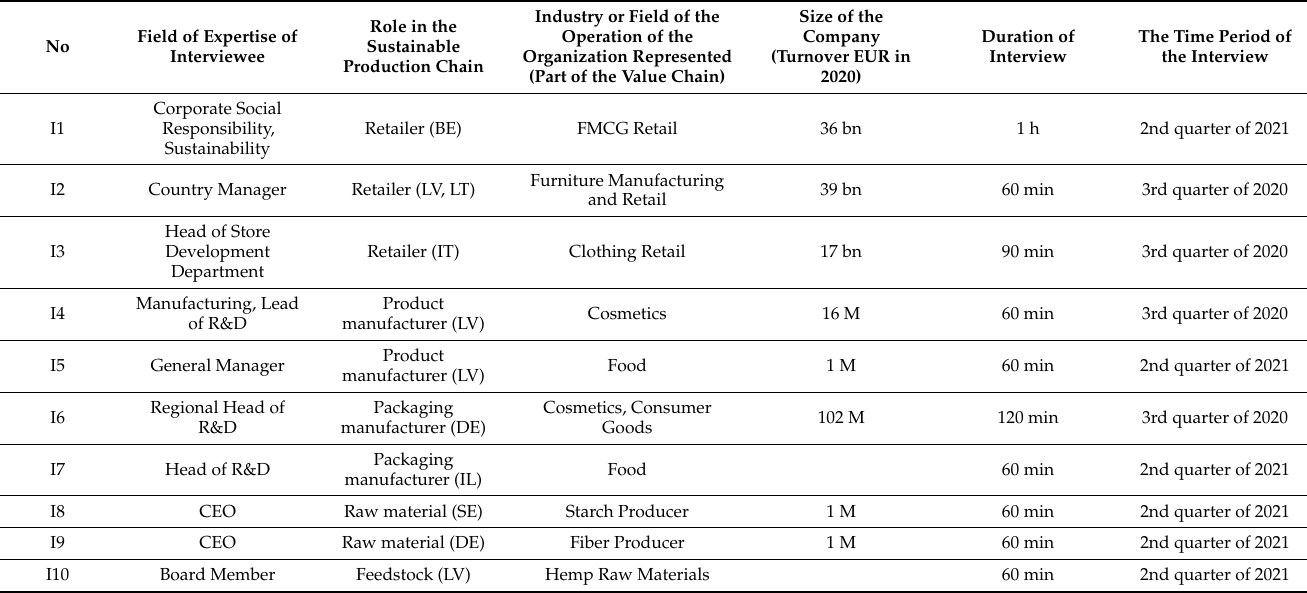
Table A1. Characteristics of the